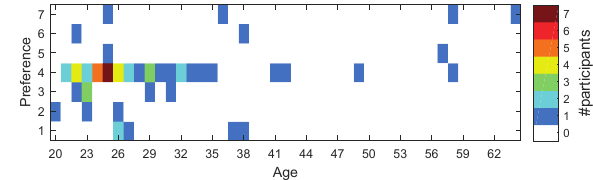
Figure 5: Correlation between age of participants and their prefer- ence for human (1) versus robot (7) health assistants